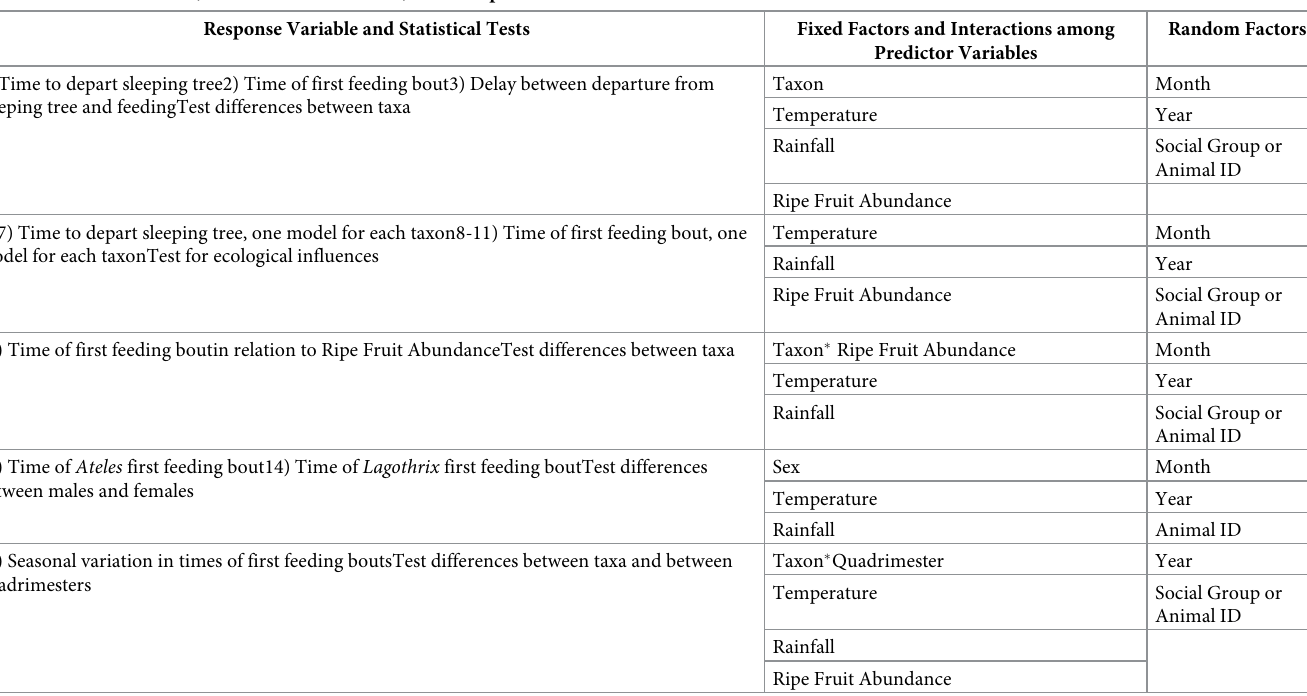
Table 1. Statistical models, factors and interactions, and tests